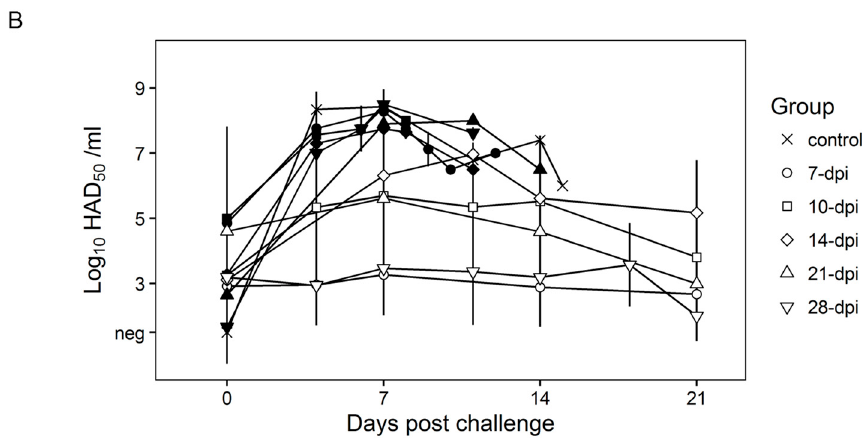
Figure 4. Rectal temperature ( A ) and viremia ( B ) in Pret4 ∆ 9GL virus-infected animals challenged with Pret4 virus at different times. Average and SD of each group along a 21-day observational period is presented. Viremia values are expressed as log 10 HAD 50 /mL. Limit of detection: 1.5 HAD 50 /mL. Survival status of swine is indicated as survived (white open shapes) or did not survive (black filled shapes). Dpi: days post infection.